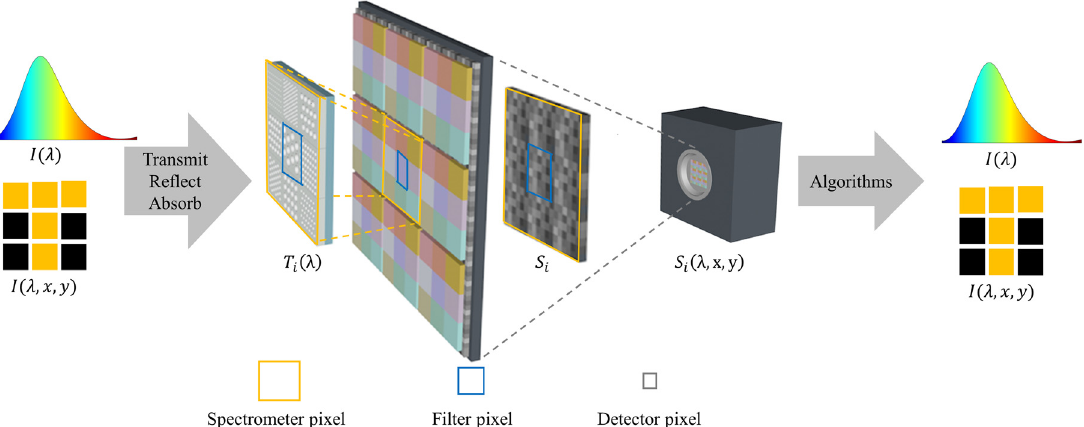
Figure 1: The major components and common operation mechanisms of computational spectrometers. Transmitted, reflected, or absorbed spectra are filtered by multiple nanophotonic structures, each with distinct response functions. The wavelength-dependent light signal is collected by sensor pixels and used for computational spectrum